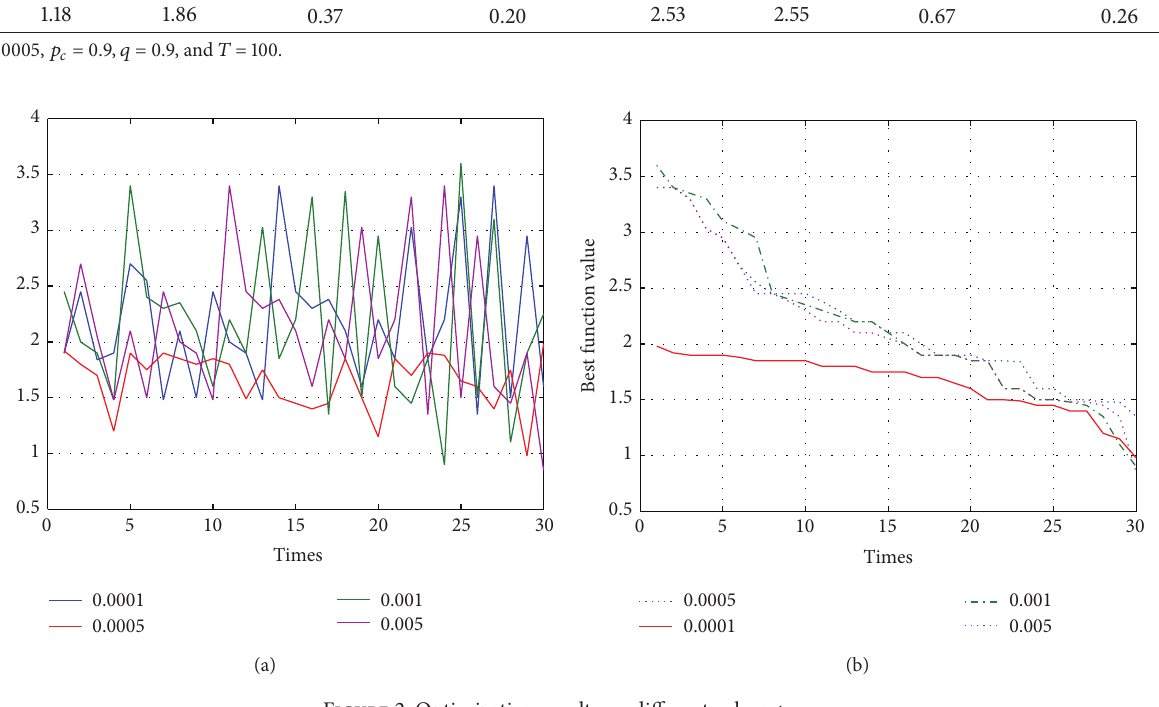
Figure 2: Optimization results on different values 𝑝 𝑚 .